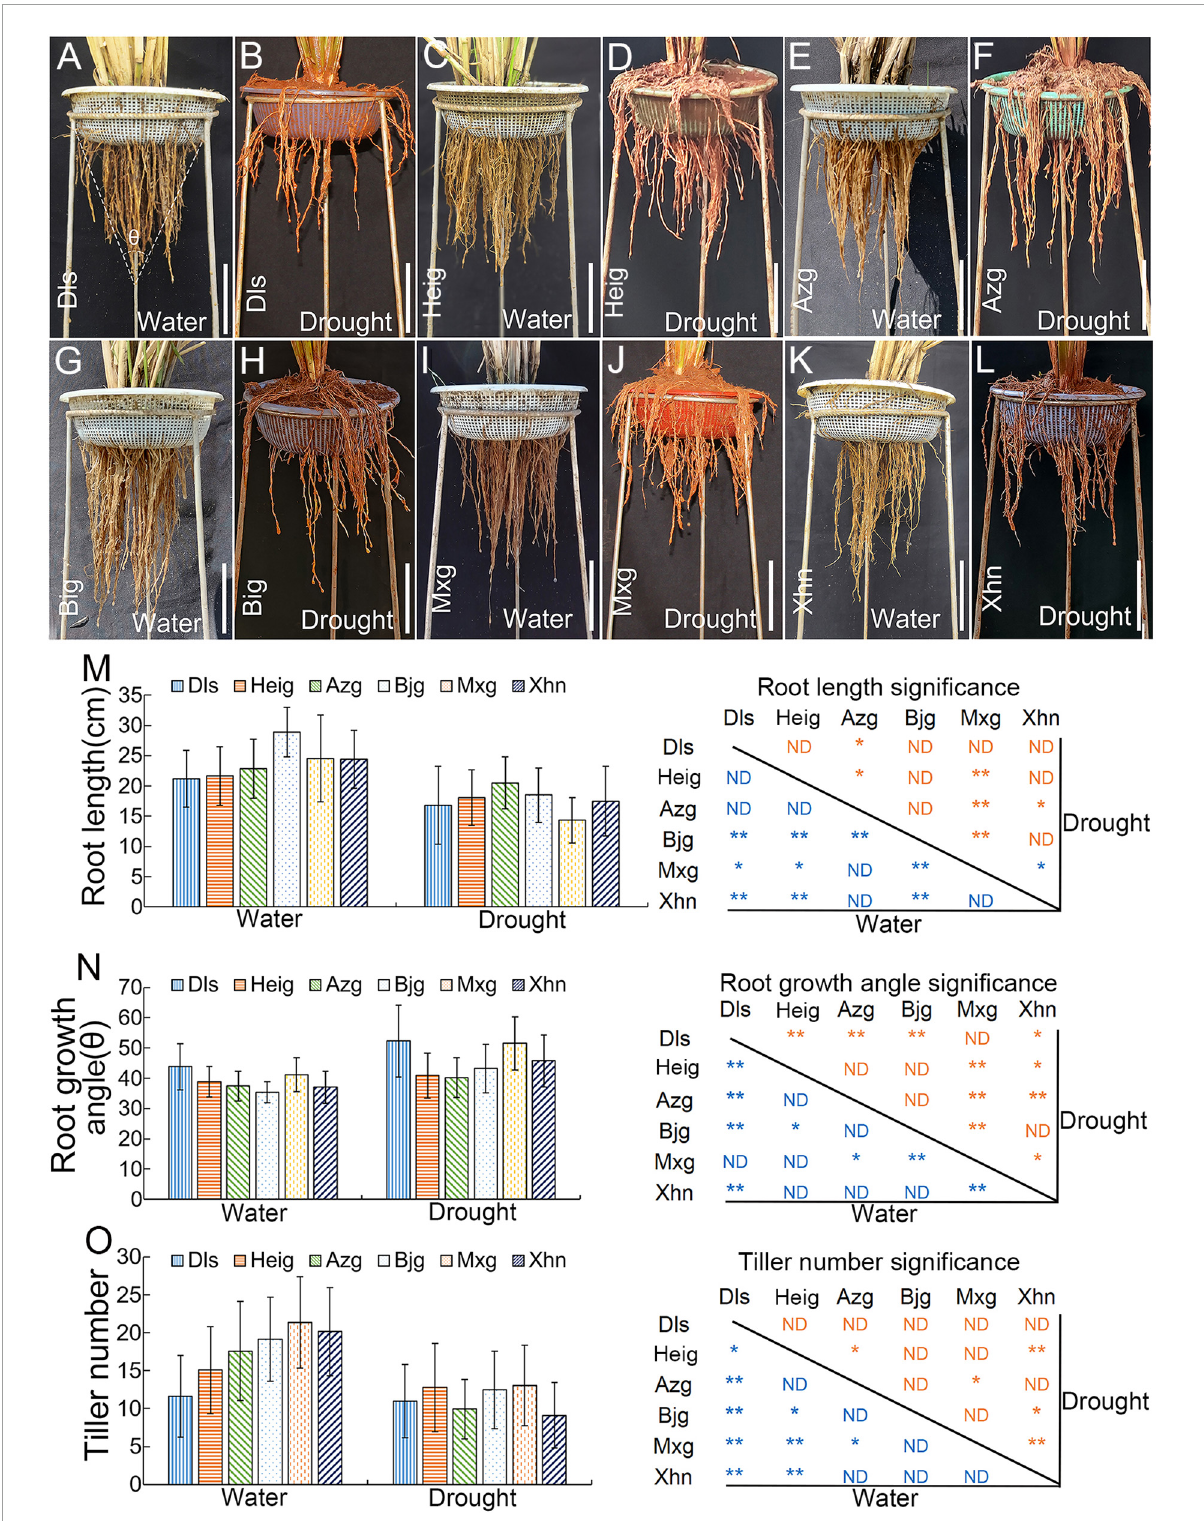
FIGURE1 Root and tiller phenotypes of six rice varieties grown under field condition. Six rice varieties Dls (A,B) , Heig (C,D) , Azg (E,F) , Bjg (G,H) , Mxg (I,J) , and Xhn (K,L) were grown under irrigation conditions (A,C,E,G,I,K) or drought stress (B,D,F,H,J,L) for 5 months. Quantification of root lengths (left) and significance (right) (M) , root growth angles (left) and significance (right) (N) , tiller numbers (left) and significance (right) (O) . Data are means ± SD. * P < 0.05, ** P < 0.01 (Tukey’s HSD test). ND, no difference; Dls, Da Leng Shui; Heig, Hei Gu; Azg, Ai Zhe Gu; Bjg, Ban Jiu Gu; Mxg, Ma Xian Gu; Xhn, Xiao Hua Nuo; θ , root growth angle. Scale bar = 10